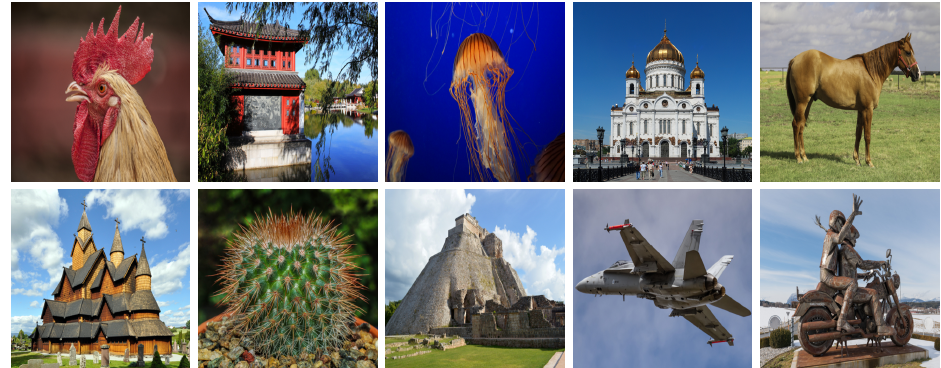
Figure 3. The images from the DIV2K dataset.